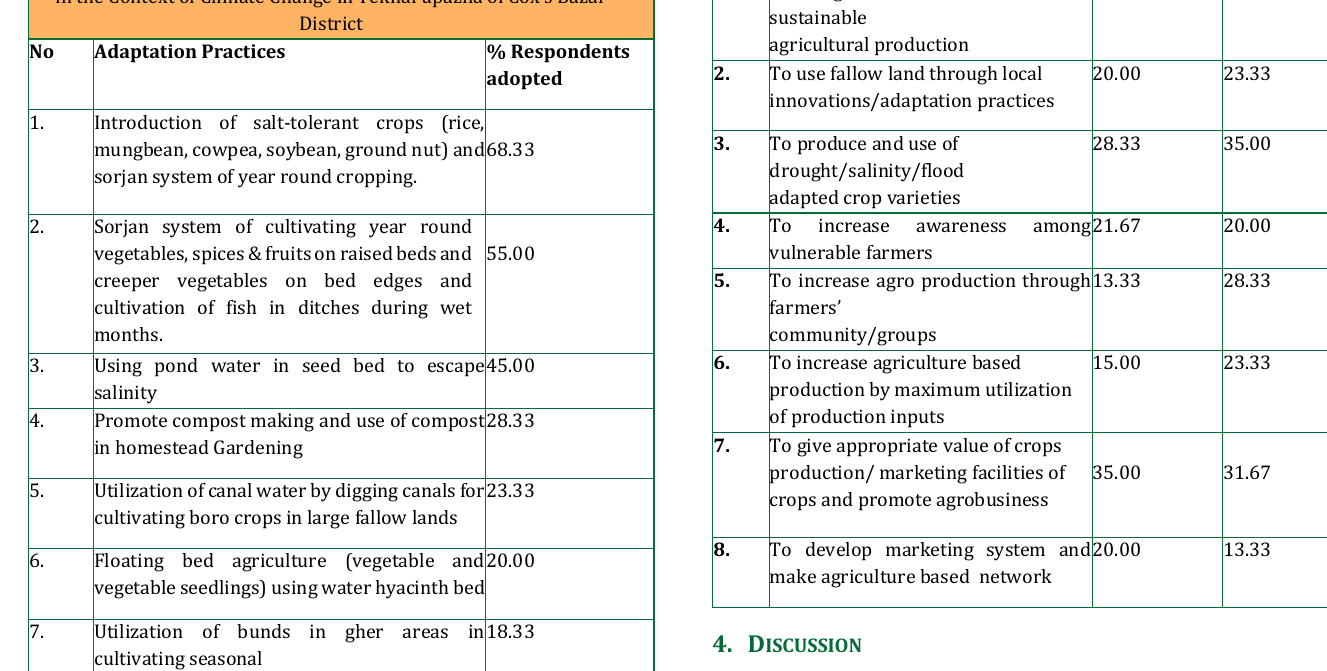
Table 4: Adaptation Practices for Sustainable Agricultural Production in the Context of Climate Change in Teknaf upazila of Cox’s Bazar